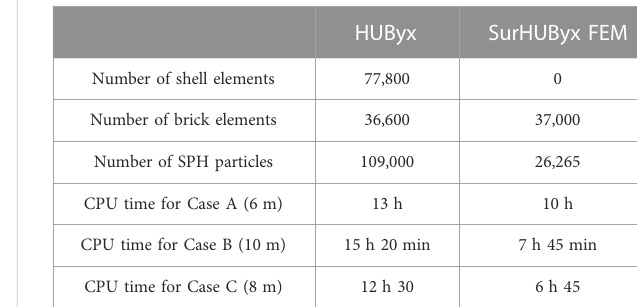
TABLE 4 Vc max comparisons between cadaveric experiments, HUByx and SurHUByx: Numerical comparison between HUByx and SurHUByx